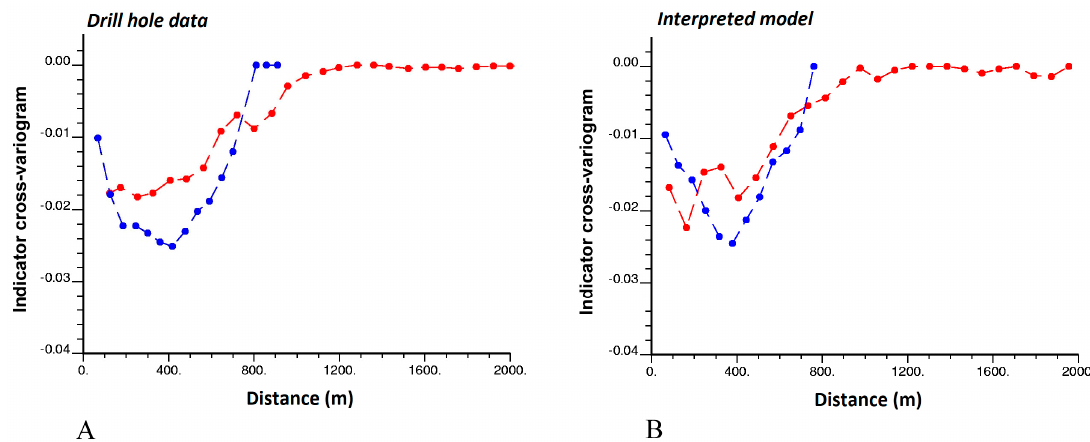
Figure 9. Indicator cross-variogram between rock types 4 (granodioritic porphyry) and 5 (monzonitic porphyry) along directions dipping 75° (blue) and − 15° (red) with respect to the north direction, calculated from ( A ) drill hole data, ( B ) interpreted model. Calculations consider an angle tolerance of 20° around the target directions. The same lag values have been used for both cross-variograms.